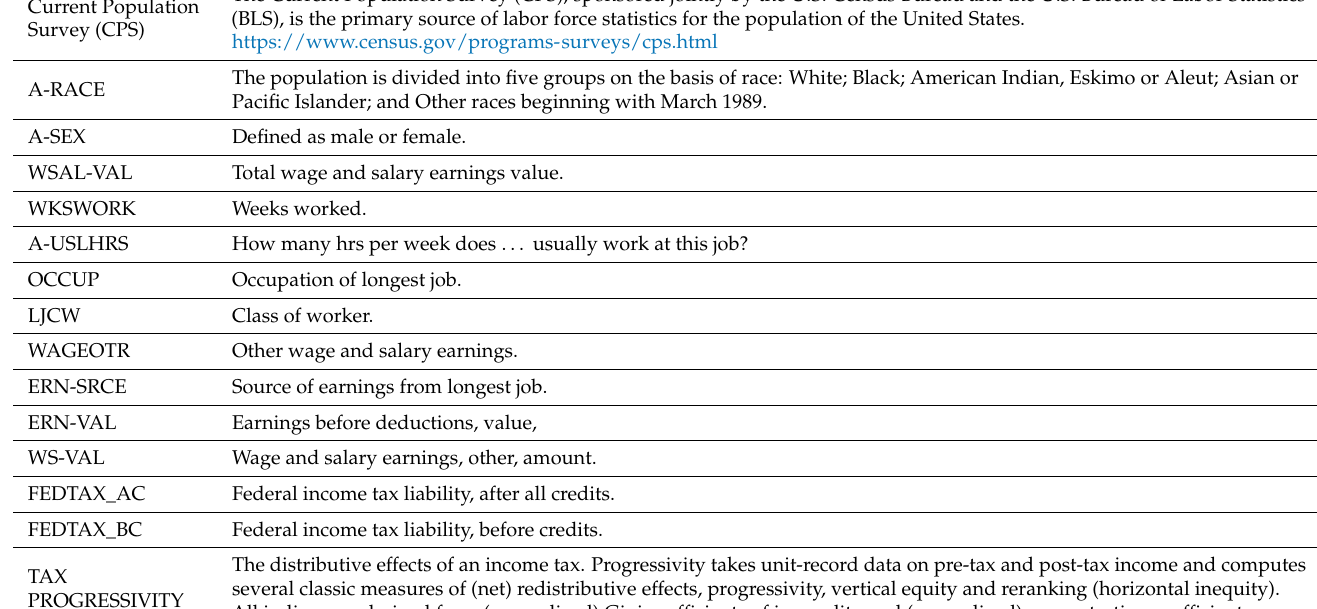
Table A1. Variable